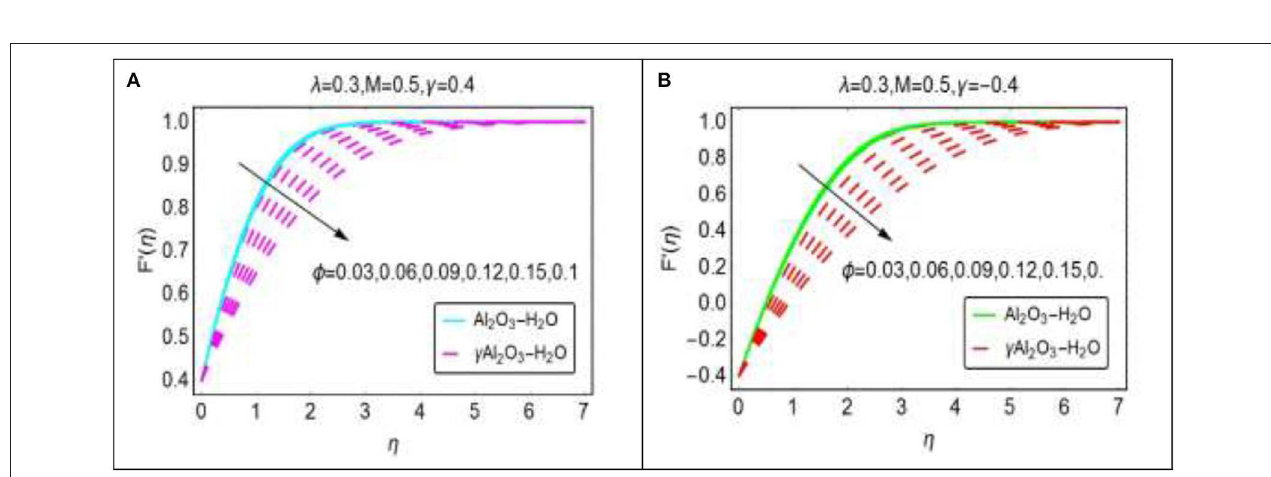
Frontiers in Physics |